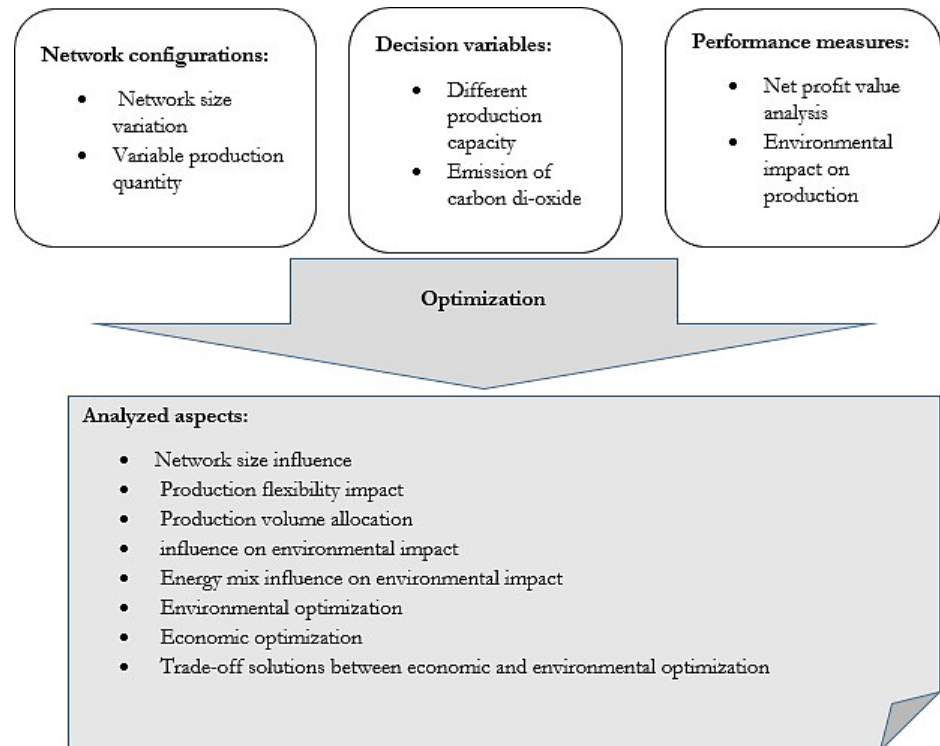
Fig. 2. Conceptual framework for a both economic and ecological GSCM planning